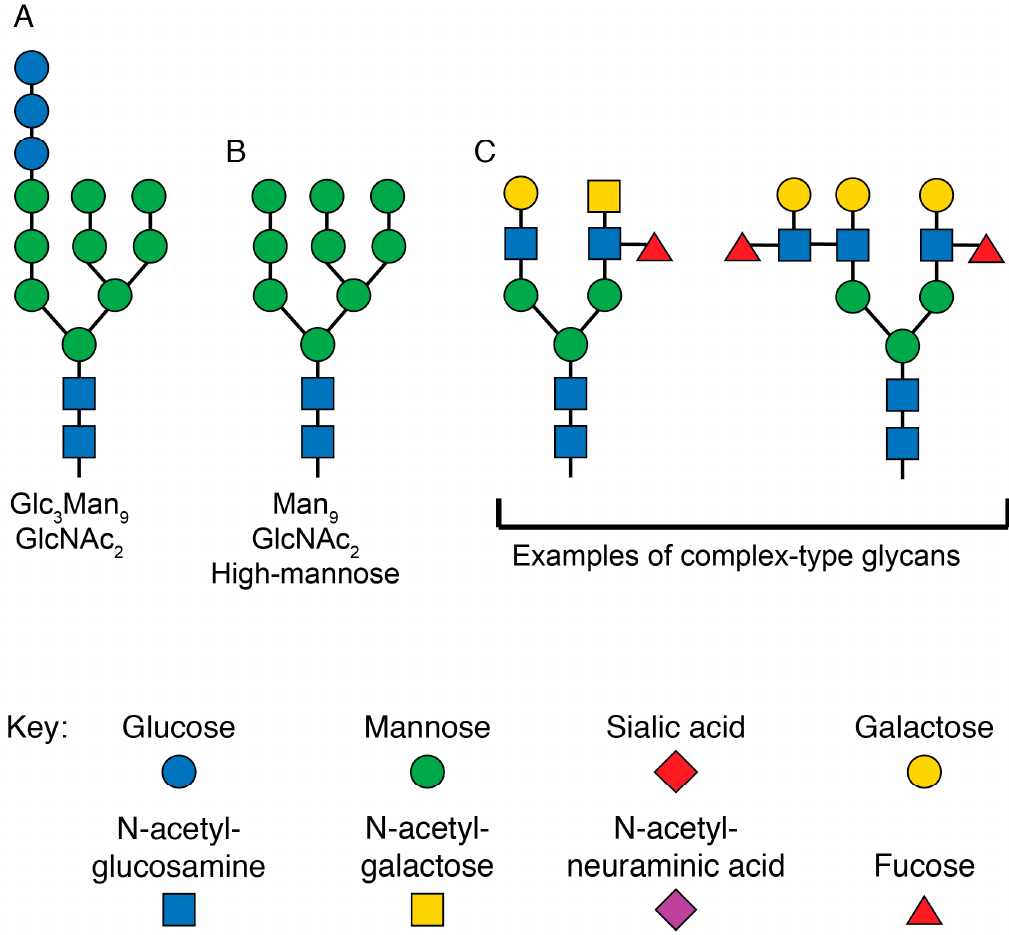
Figure 4. Structures of glycans at various stages of N-linked glycosylation. ( A ) Graphical depiction of the glycan structure transferred to all N-linked glycosylation sites by the enzyme complex oligosaccharyltransferase in the rough ER. The three terminal glucose monomers are removed before exiting the ER. ( B ) Graphical representation of the high-mannose glycan at N-linked glycosylation sites as newly synthesized proteins enter the Golgi. For certain sites on HIV Env, this is the final form of the glycan. ( C ) Graphical representation of two complex-type glycans that are present on mature eukaryotic proteins. These are just two of the dozens of forms the final mature glycan structure can take. The sugar monomers are drawn according to the updated recommendations for symbol nomenclature for glycans [133].